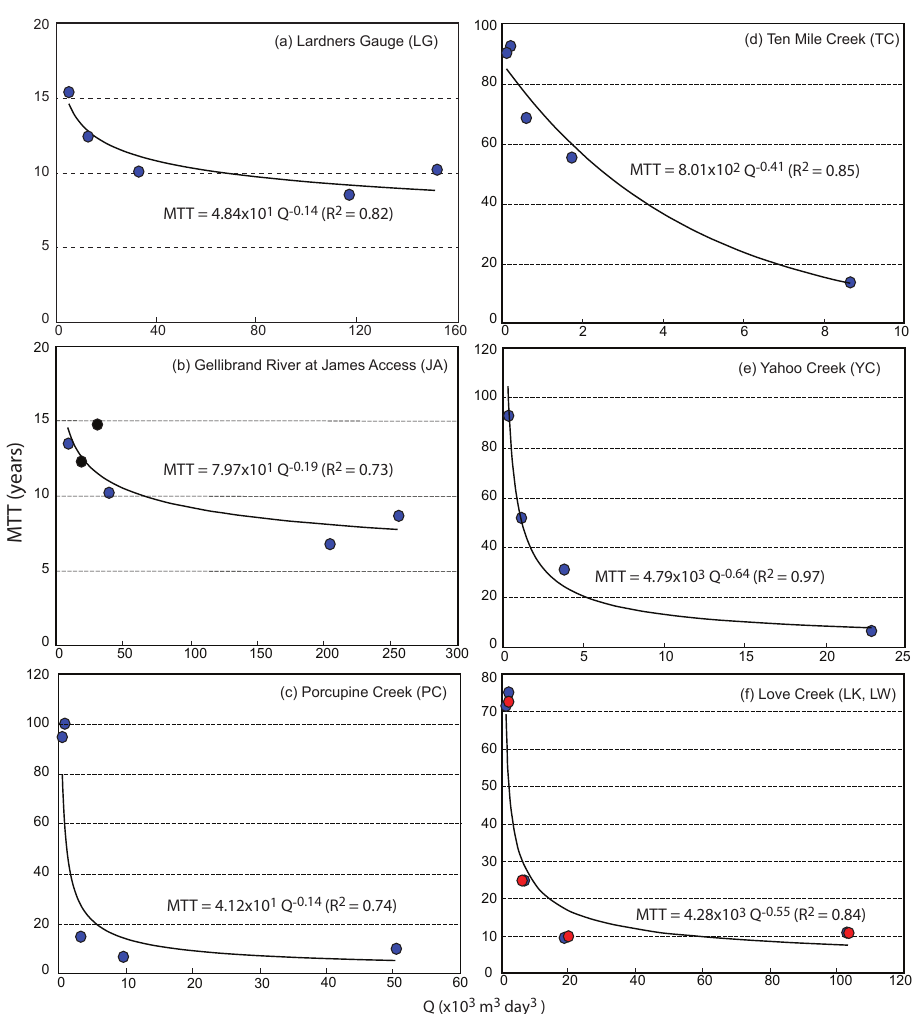
Figure 8. MTTs calculated using the EPM model with an EPM ratio of 1.0 (Table 3) as a function of streamflow ( Q ) for Lardners Gauge (a) , Gellibrand River at James Access (b) – black circles are data from Atkinson (2014), Porcupine Creek (c) , Ten Mile Creek (d) , Yahoo Creek (e) , and Love Creek (f) – blue circles are Love Creek Kawarren and red circles Love Creek Wonga. Curves are exponential trend lines. Streamflow data from Department of Environment, Land, Water and Planning (2017) or calculated as discussed in the